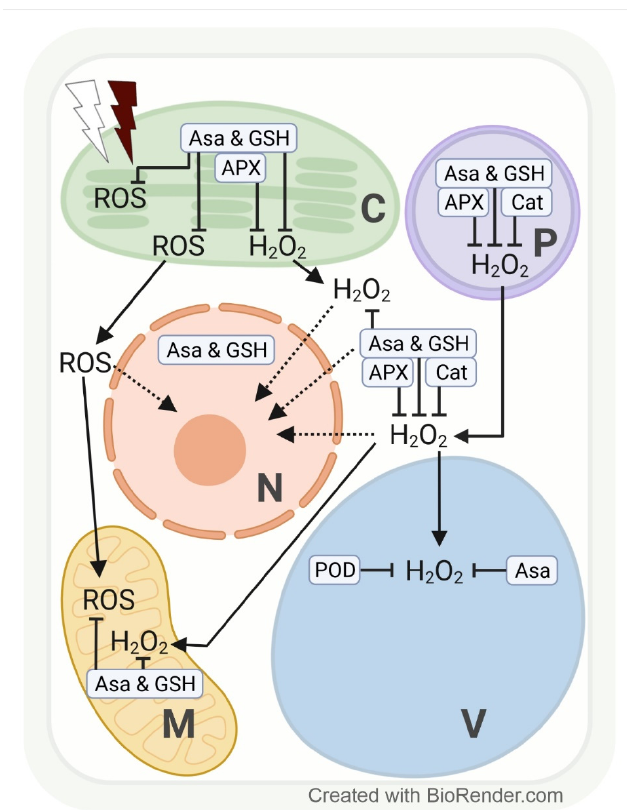
Figure 3. Effects of excess white and far-red light on the subcellular production of reactive oxygen species (ROS), with special emphasis on hydrogen peroxide (H 2 O 2 ) and its compartment-specific detoxification by antioxidants (ascorbate, AsA; and glutathione, GSH) and enzymes in plants. Line drawing proposing a model of the effects of excess white light (white thunderbolt) and far-red light (dark red thunderbolt) on the subcellular accumulation of H 2 O 2 (and other ROS). Possible signalling pathways are indicated by dotted arrows. APX, ascorbate peroxidase; C, chloroplast; Cat, catalase; M, mitochondria; N, nucleus; P, peroxisome; POD, guaiacol-type peroxidase; V, vacuole.